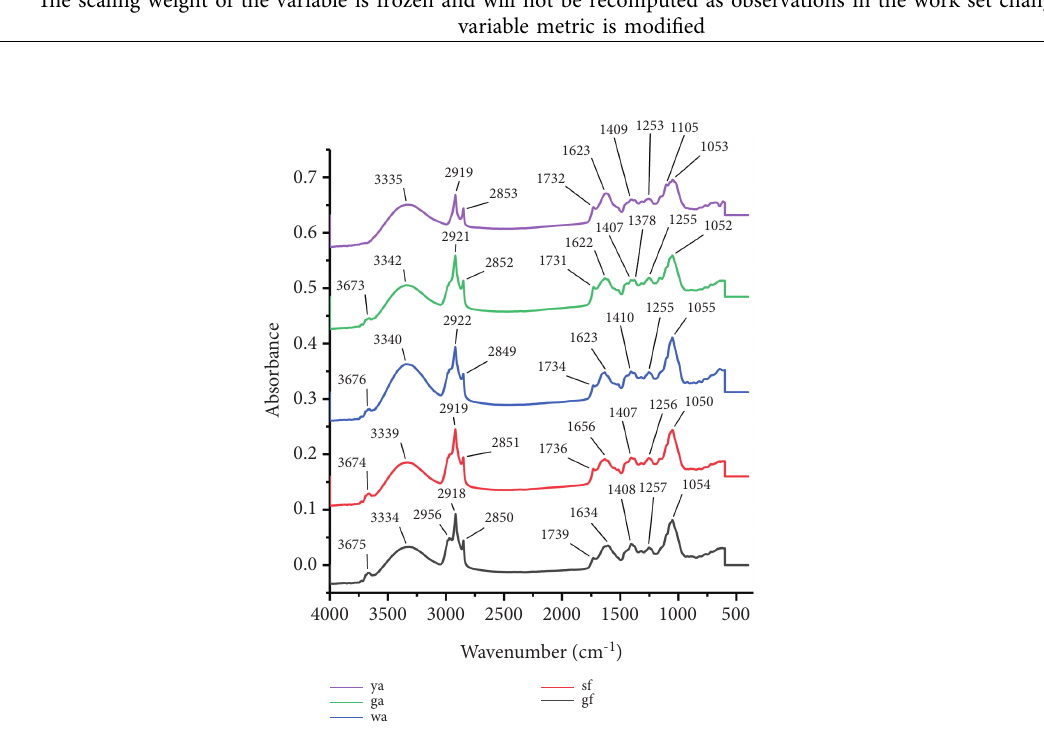
Figure 2: ATR-FTIR fingerprint of Lonicera japonica in different harvesting periods.